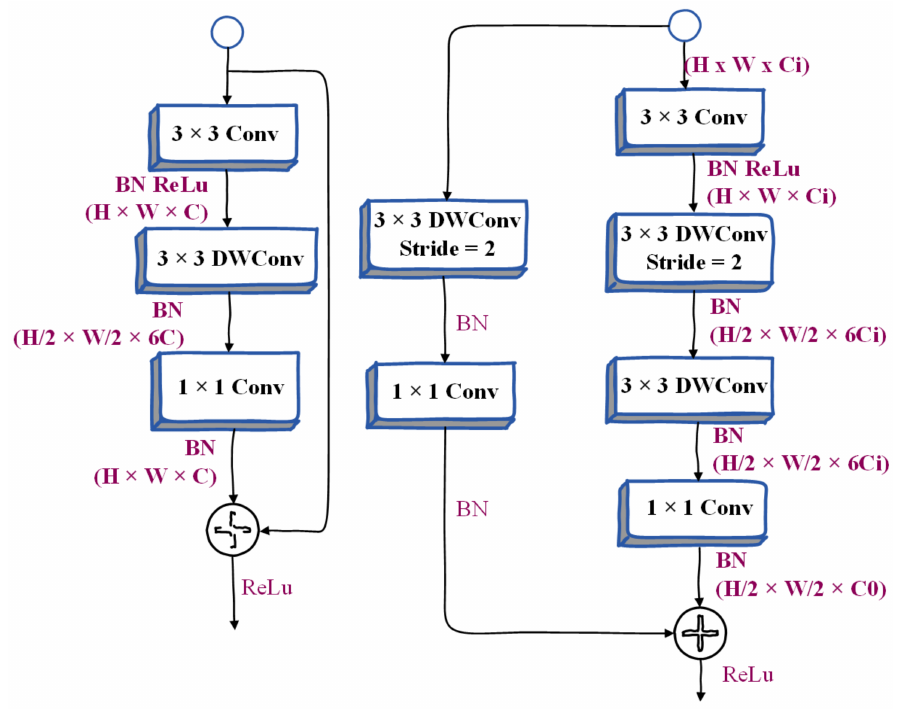
Figure 5. Illustration of Inverted Bottleneck and Gather-and-Expansion